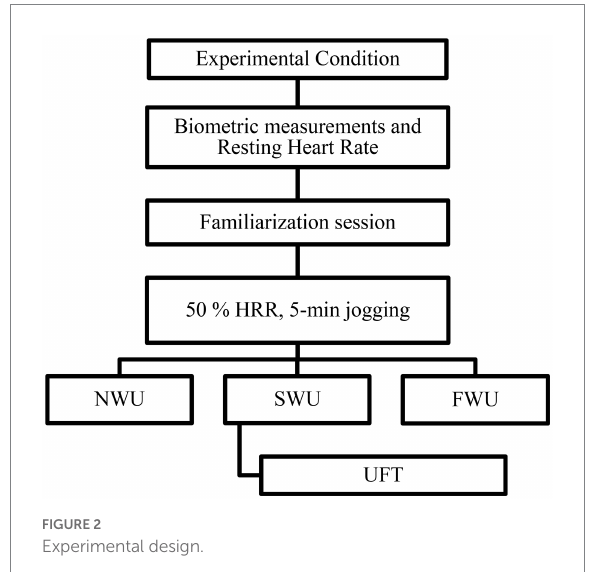
FIGURE 2 Experimental design.